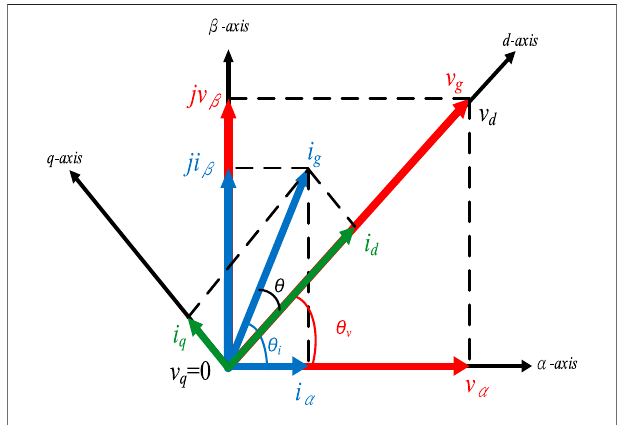
FIGURE5| Therelationshipbetweendecouplingcontrolofsingle-phase inverter system on the reference coordinate axis.